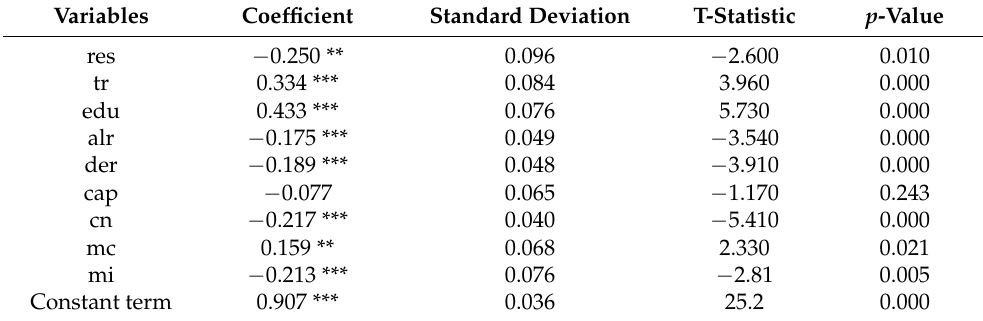
Table 4. Basic regression